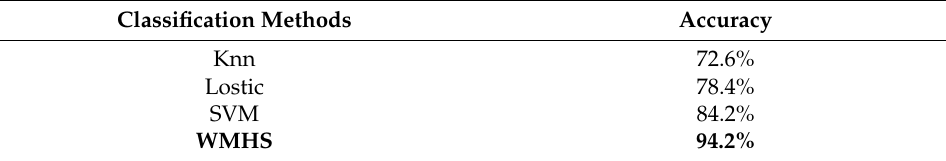
Table 2. Playback attack.